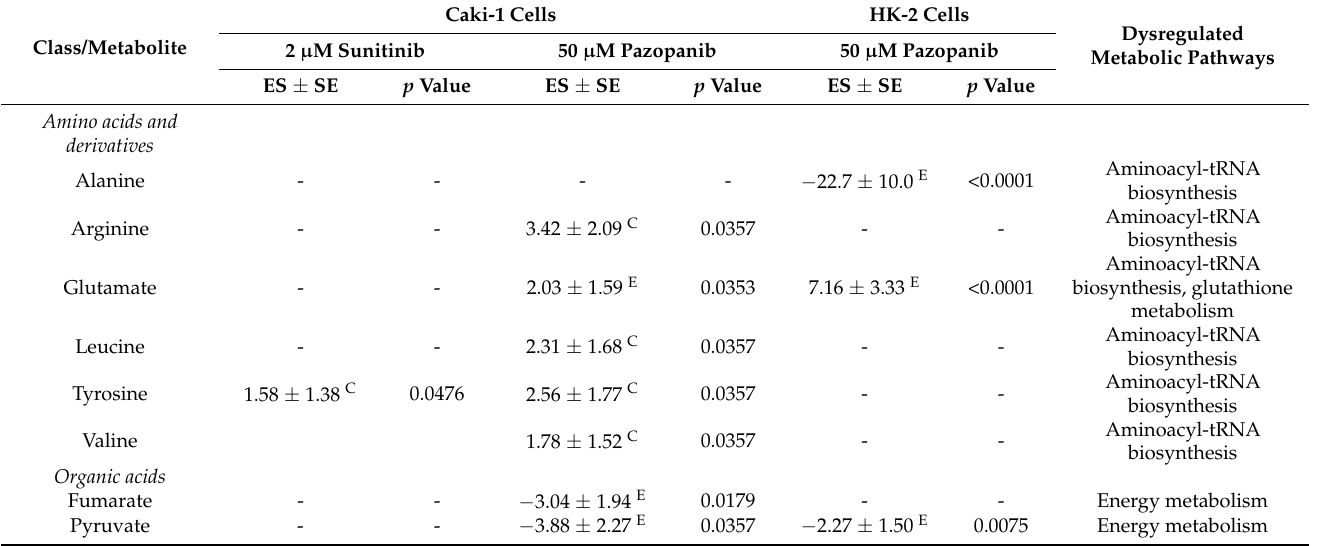
Table 2. List of metabolites significantly altered in the exometabolome (culture medium) of Caki-1 and HK-2 cells after exposure with 2 µM sunitinib or 50 µM pazopanib in comparison with the corresponding non-exposed cells (control).